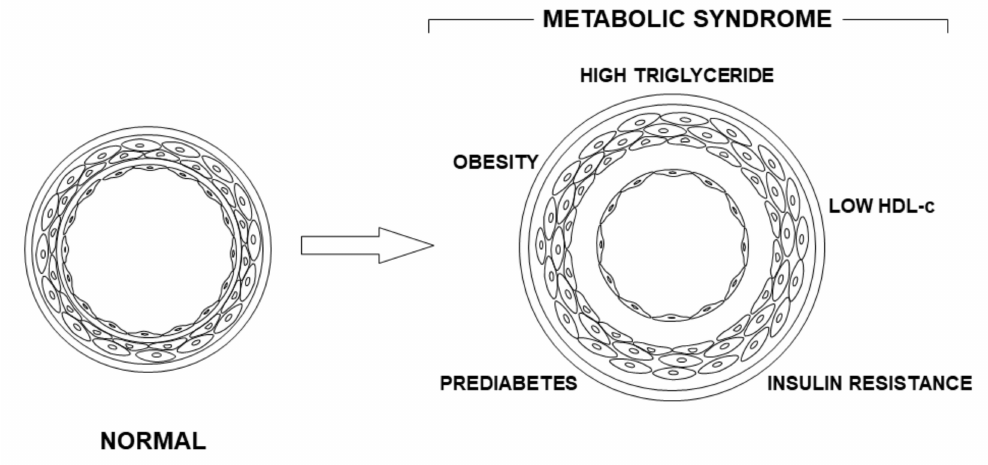
Figure 1. Postulated pathogenesis of the arterial stiffness. The figure shows the normal wall artery structure ( left ) and another with abnormal stiffness ( right ). The later shows an increased vascular diameter together with hypertrophy, a proliferation of smooth muscle cells, and an increased fibrosis of the intima